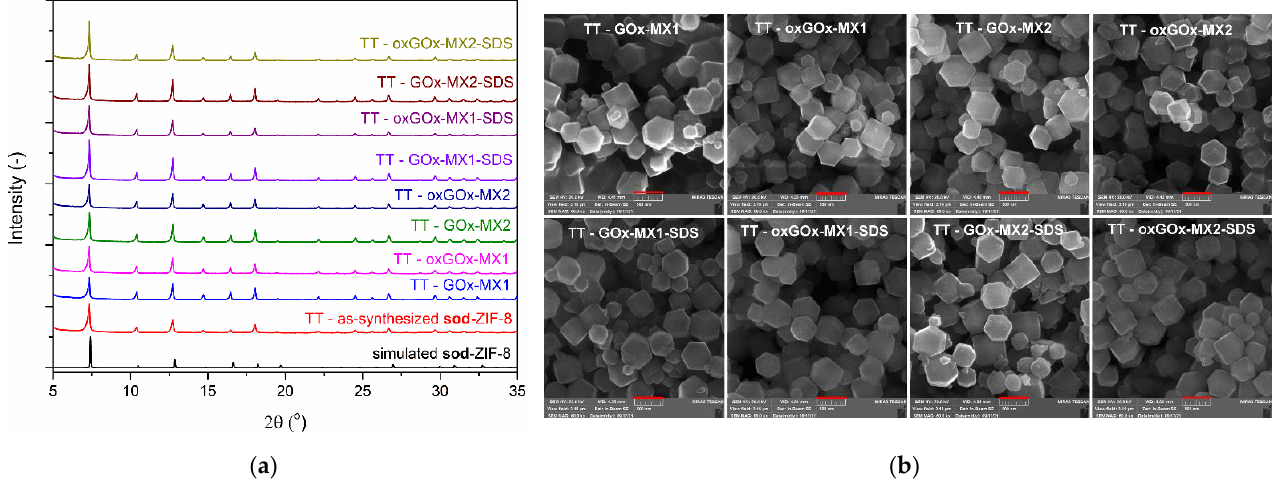
Figure 5. ( a ) PXRD diffractograms of the biocomposites washed with SDS after thermal treatment; ( b ) SEM images of the biocomposites washed with SDS after thermal treatment (scale bar 500 nm). biocomposites washed with SDS after thermal treatment (scale bar 500